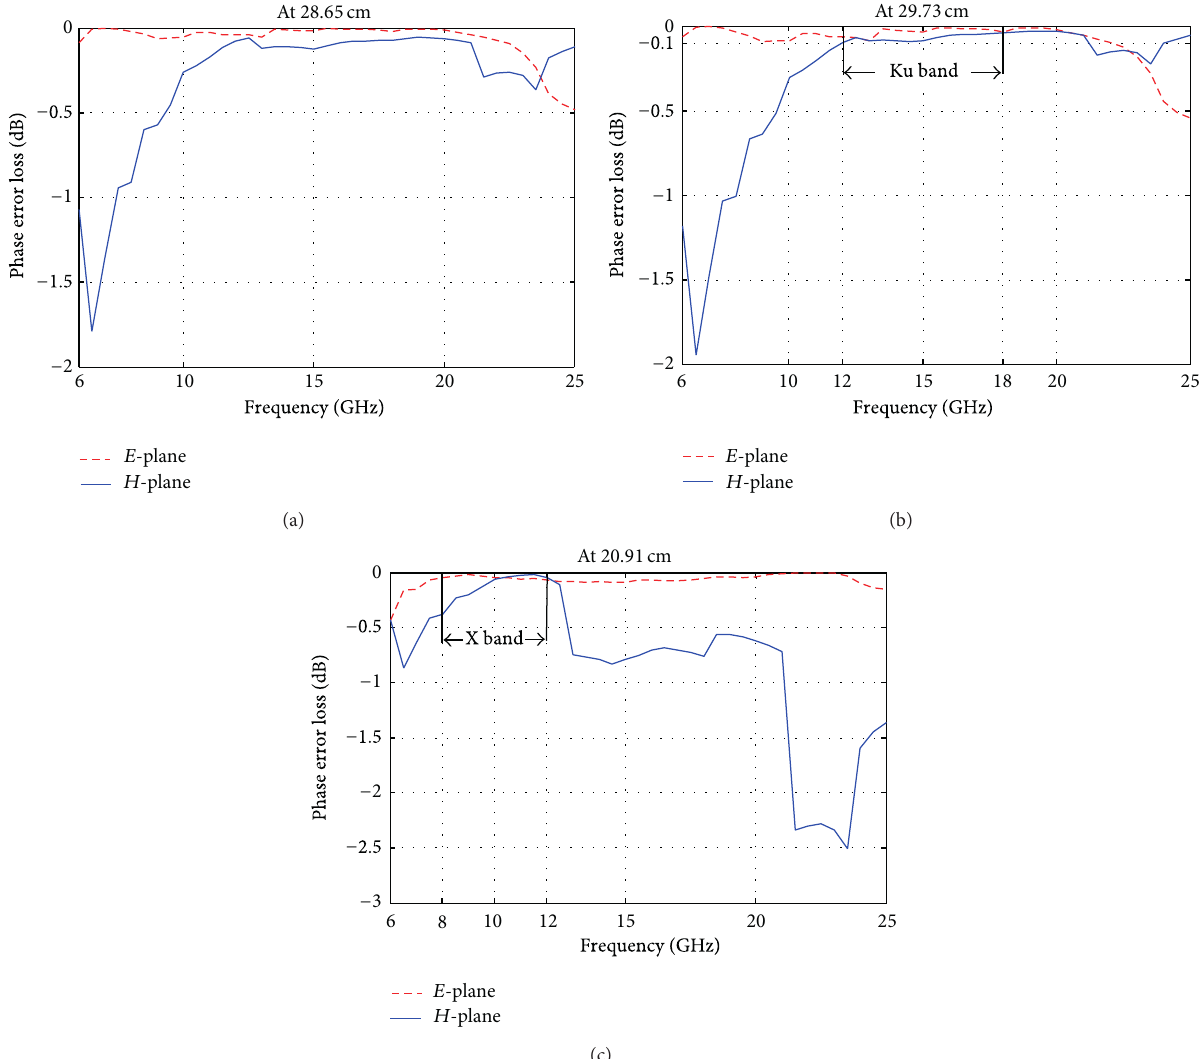
This distance between phase center locations at lowest and highest frequencies will cause the phase error losses due to axial